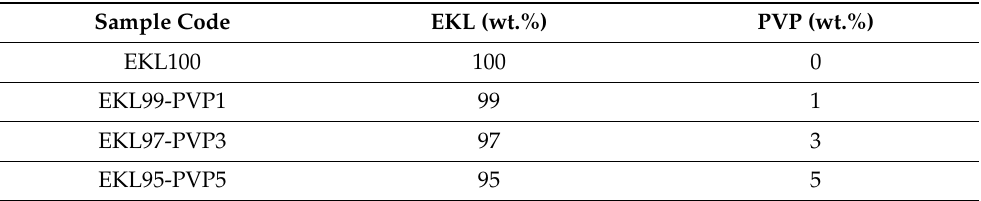
Table 1. Nomenclature and concentration for samples